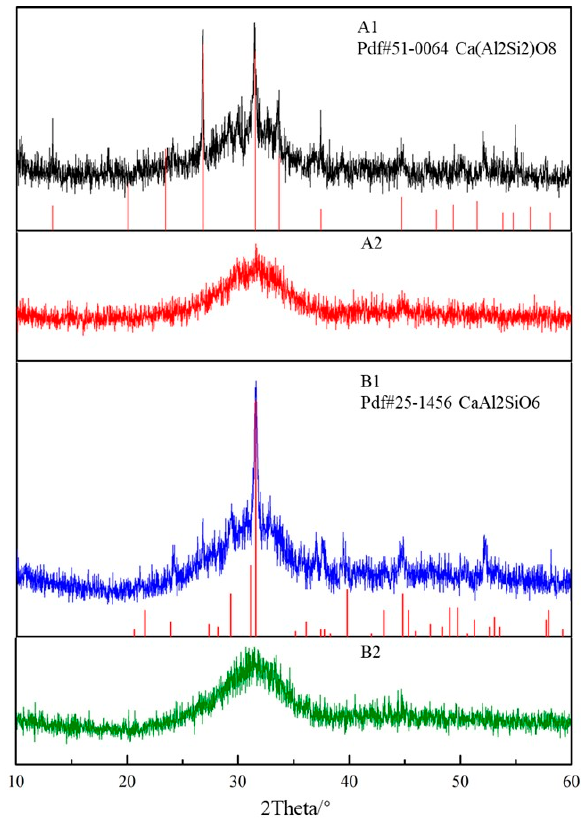
Figure 9. XRD results for tundish covering flux samples before and after plasma heating: A1, A group: before heating; A2, A group: after heating; B1, B group: before heating; B2, B group: after heating.